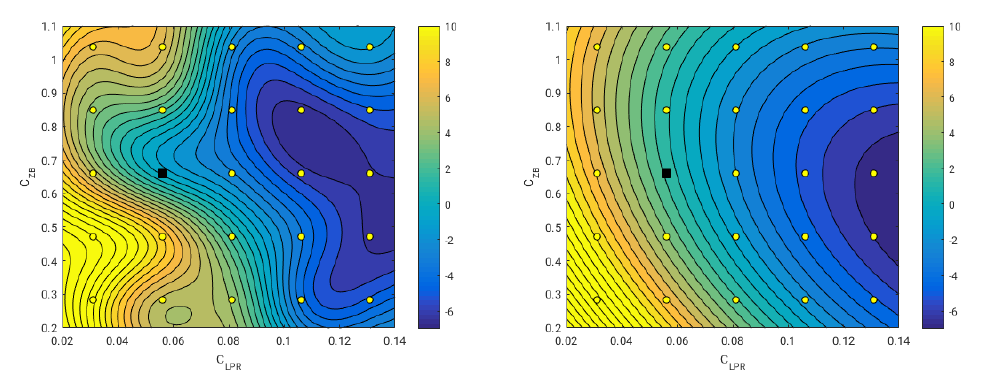
Figure 12. Left: surrogate model constructed using Kriging interpolation. Right: surrogate model constructed using quadratic polynomial interpolation. In the image, the uniform spaced points represent the locations where the high-fidelity computations were computed. The square represents the starting geometry and the circles represent the new geometries. In both images, the color scale represents the resistance variation in reference to the original geometry (where negative values indicate resistance reduction, and positive values indicate resistance